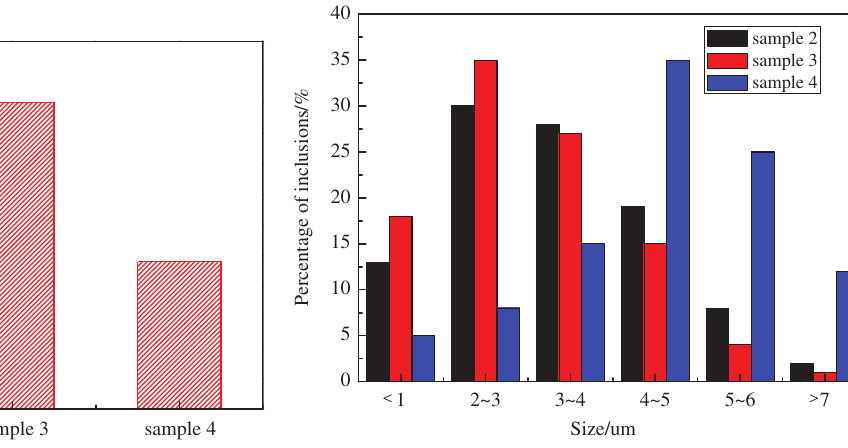
Figure 8: Quantity density of the effective La 2 O 2 S inclusions. Figure 9: Size distribution of the La 2 O 2 S